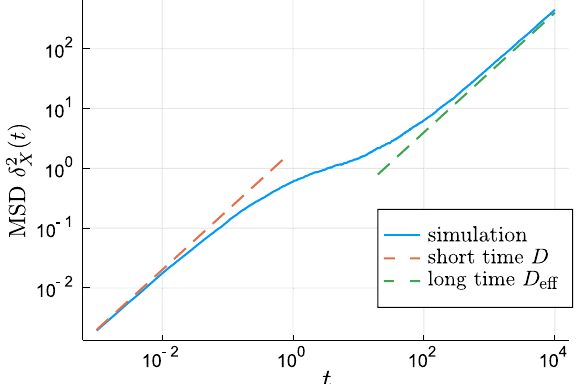
1, 1, κ 1 / 50, � t 0.001 L k = � � = = = 2 Dt ∼ 2 κ Dt (green dashed ∼